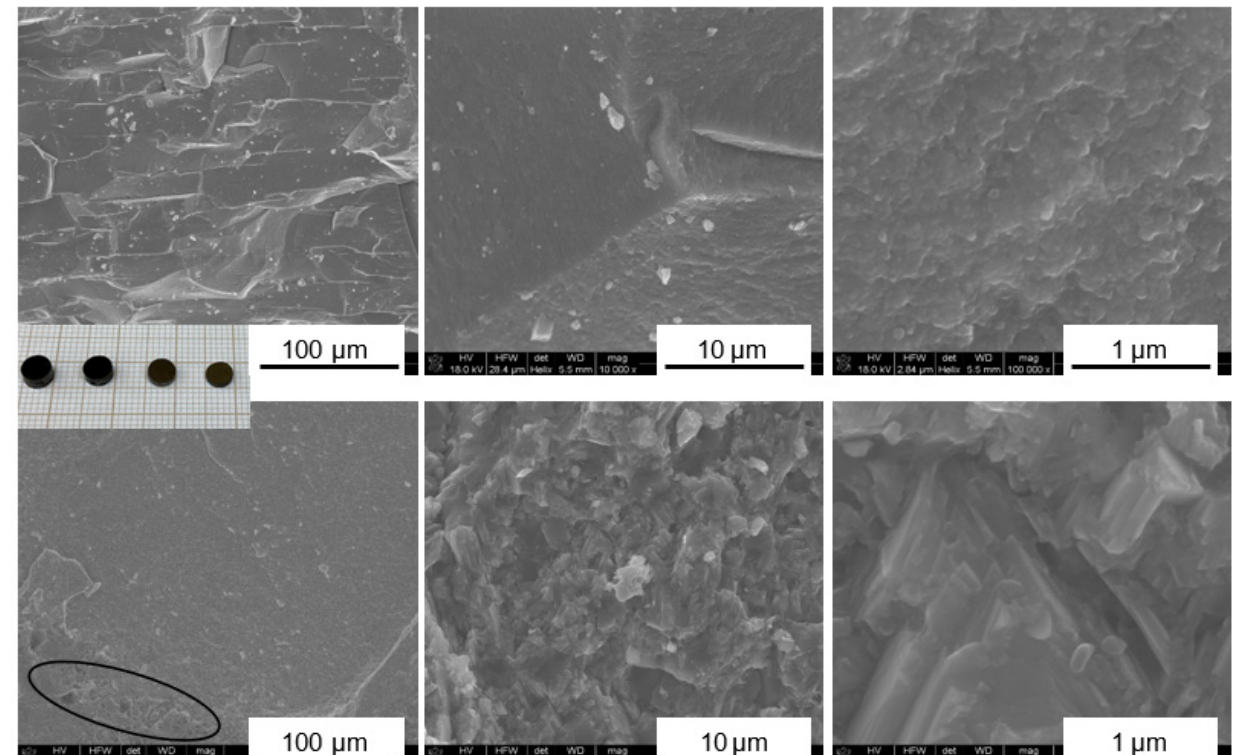
Figure 8. SEM images for the fractured pellets of prekesterite ( top row) and kesterite ( bottom row), which were prepared from the respective nanopowders in the CE system. Insert on the left—a snapshot of sintered pellets. Note a small region of macroporosity in kesterite shown in oval, in which micro-sized texturing is observed (lower